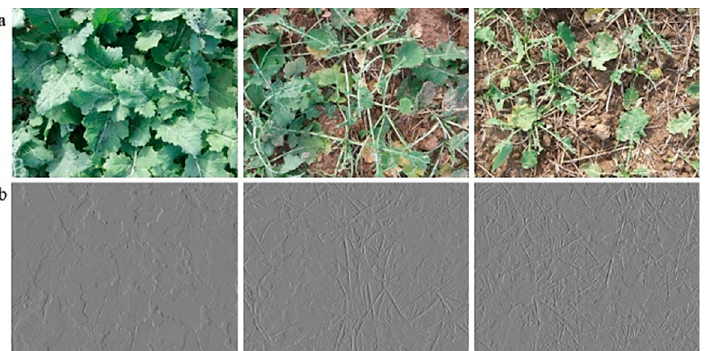
Figure 5. Extraction of initial information of input images in Vgg16. ( a ) original images ( b ) corre- sponding output of the first layer from 90th filter of Vgg16.